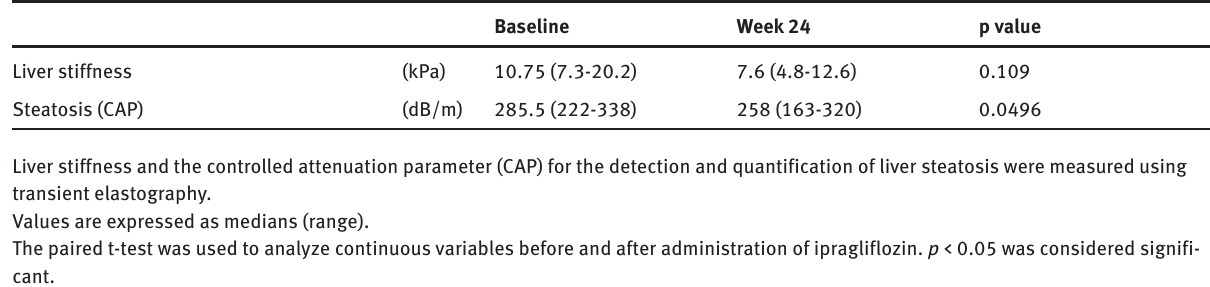
Table 4: The effect of ipragliflozin on liver stiffness and steatosis in six patients